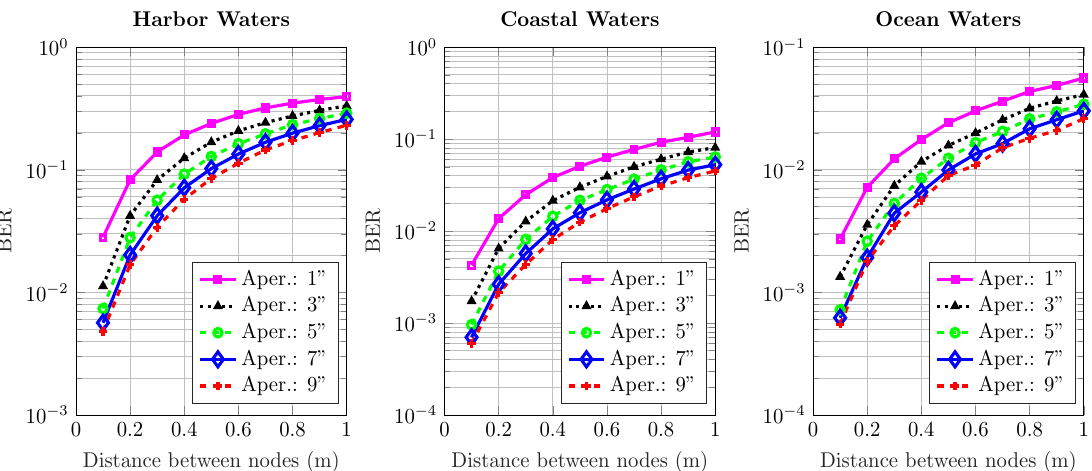
Figure 7. Effect of increasing transmission distance and aperture on the BER performance of harbor, ocean, and coastal waters for 18 ◦ receiver FoV.